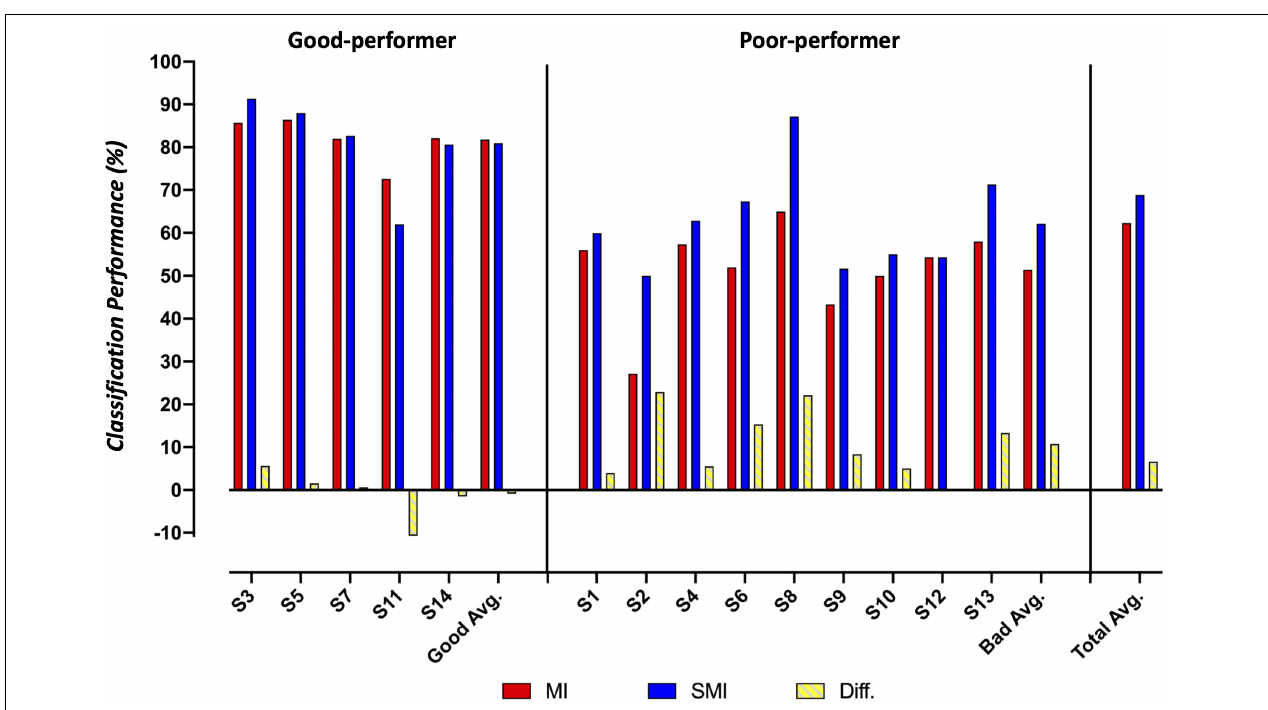
FIGURE 5 | Comparison of the classification accuracy for motor imagery and somatosensory-motor imagery conditions between good and poor performer